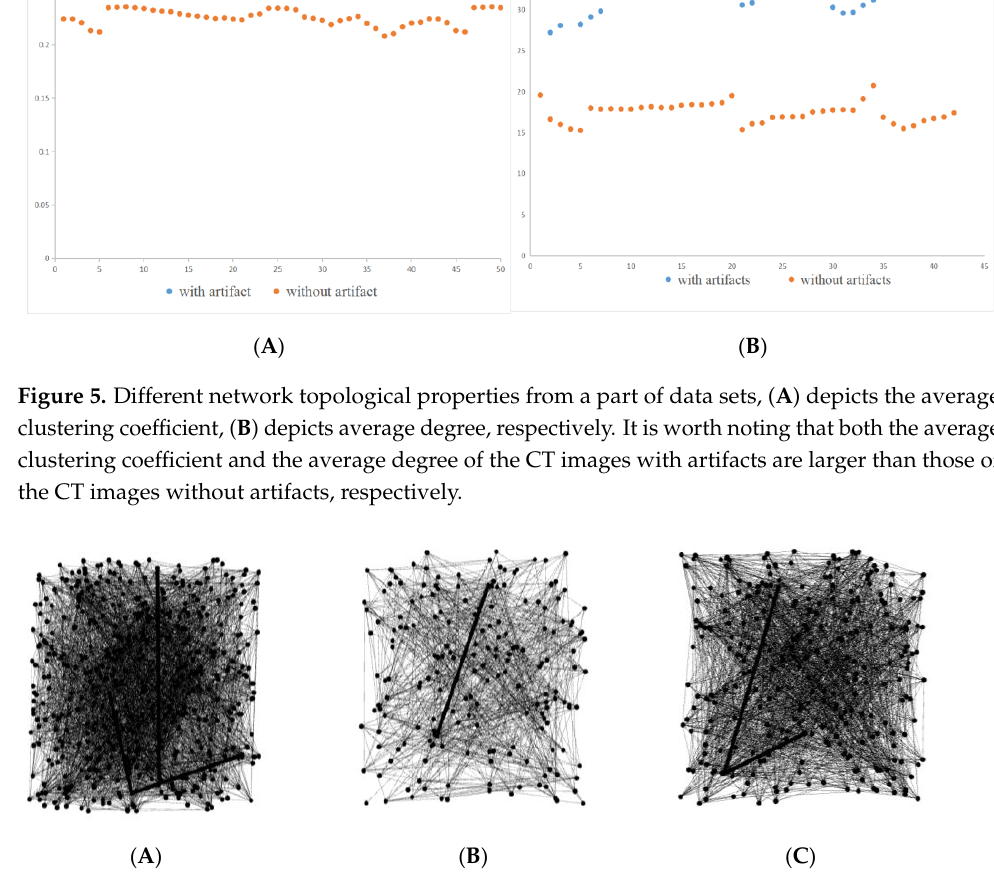
Figure 6. The constructed graphs using slice-level graph construction method. ( A ) is the hybrid graph which consists of head CT slices with motion artifacts and head CT slices without artifacts, ( B ) contains head CT slices without artifacts alone, ( C ) contains head CT slices with artifacts alone.